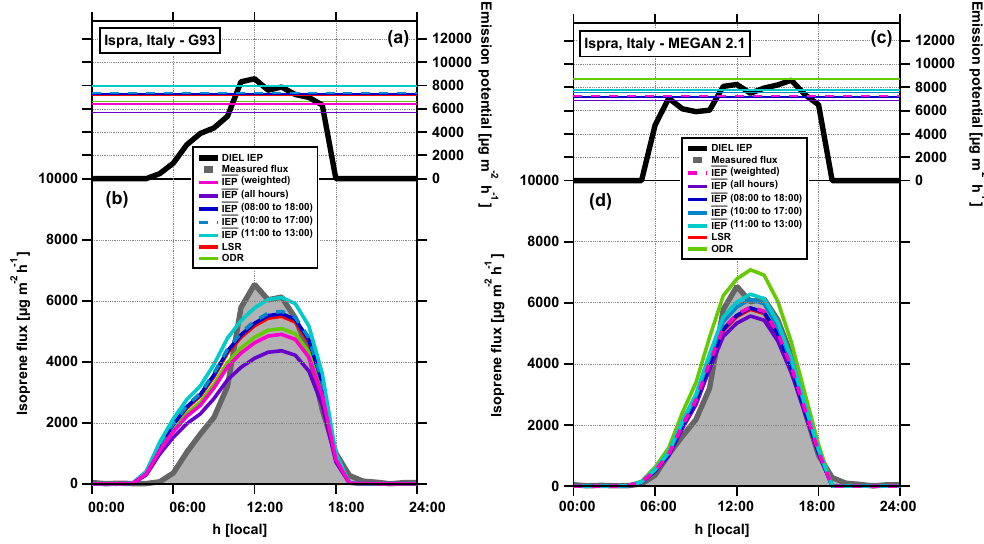
(cid:16) F (cid:17) iso ) calculated for the Ispra forest γ =